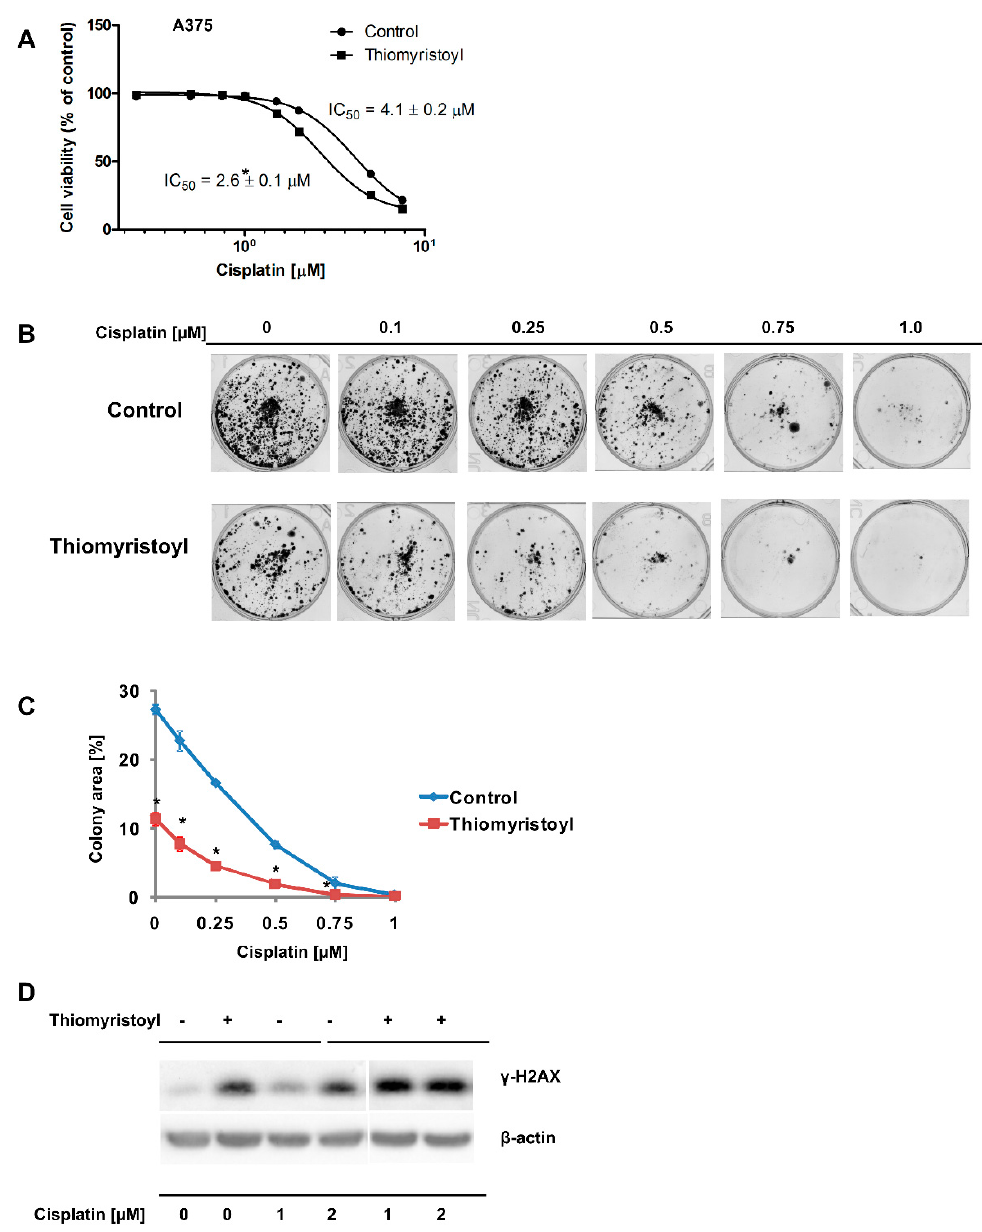
Figure 3. Pharmacological inhibition of SIRT2 sensitizes melanoma A375 cells to cisplatin. ( A ) The effects of cisplatin treatment (96 h) on the viability of control cells and those pretreated with thiomyristoyl cells were determined using the neutral red assay, mean ± standard deviation ( n = 3, independent experiments). ( B ) Results of the colony formation assay performed on control A375 cells and those pretreated with thiomyristoyl for 72 h prior to exposure to different cisplatin concentrations. Images from a single representative experiment are shown. ( C ) A colony area values from the colony forming assay is shown as the mean ± standard deviation ( n = 3, independent experiments). * Indicates a statistically significant difference at p < 0.05. ( D ) Effect of cisplatin on the accumulation of γ -H2AX in control A375 cells and those pretreated with thiomyristoyl for 72 h. Cells were treated with cisplatin for 48 h. Then, cells were harvested and protein lysates were prepared and analyzed by Western